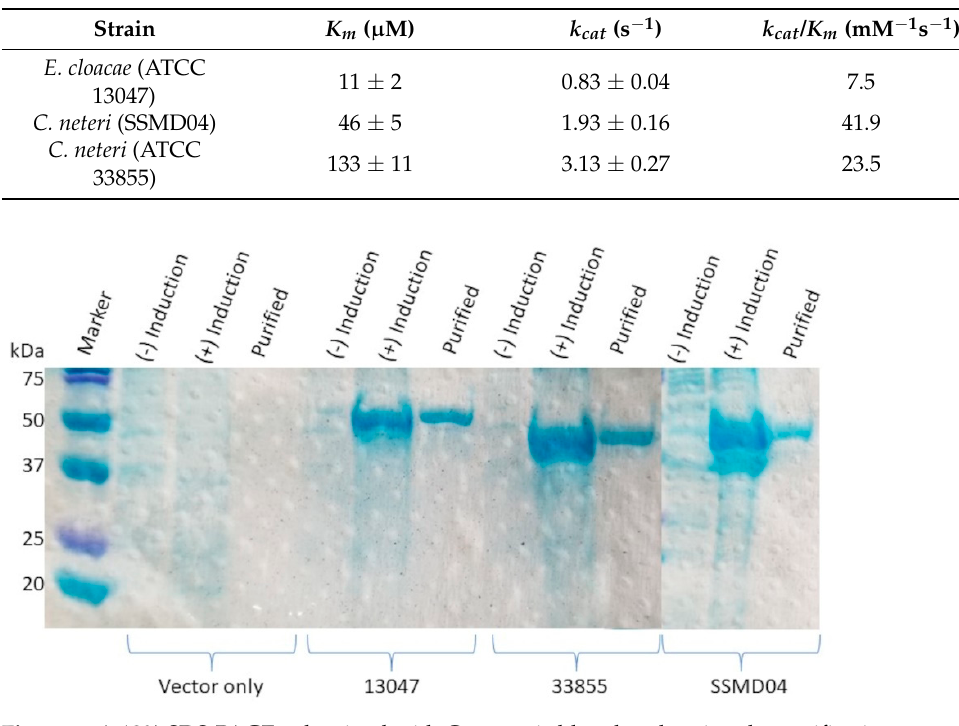
Figure 2. A 12% SDS-PAGE gel stained with Coomassie blue dye showing the purification progress and final purity of the various rAmpC proteins. The protein markers and sizes of the bands (kDa) are shown on the left. The four sets of samples are from E. coli BL21/DE3 cells containing the vector only (pET6xHN-N) and rAmpCs from E. cloacae 13047, C. neteri 33855, and C. neteri SSMD04. Each lane contains ~20 µg of total protein as determined with a BCA assay from the lysate minus induction, the lysate plus induction, and purified (after dialysis). The predicted sizes of the rAmpCs are 50.8 kDa, 45.1 kDa, and 45.4 kDa for CMH-4, CNE-2, and CNE-1, respectively.